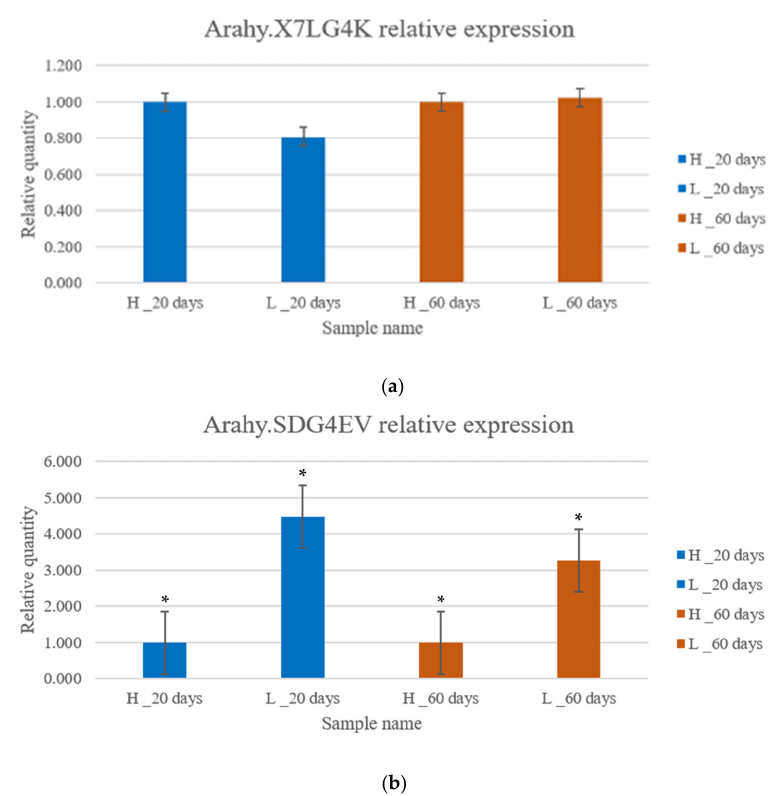
Figure 5. Gene Expression Analysis by qRT-PCR. Peanut accession H (GWP174) exhibiting high leaf-chlorophyll content and peanut accession L (GWP 411) showing low leaf-chlorophyll content at two different time points, 20 and 60 days. ( a ) Gene relative expression levels of Arahy.X7LG4K in H (GWP174) and L (GWP 411); ( b ) Gene relative expression levels of Arahy.SDG4EV in H (GWP174) and L (GWP 411). * Represents a significant difference in the two expression levels ( p <